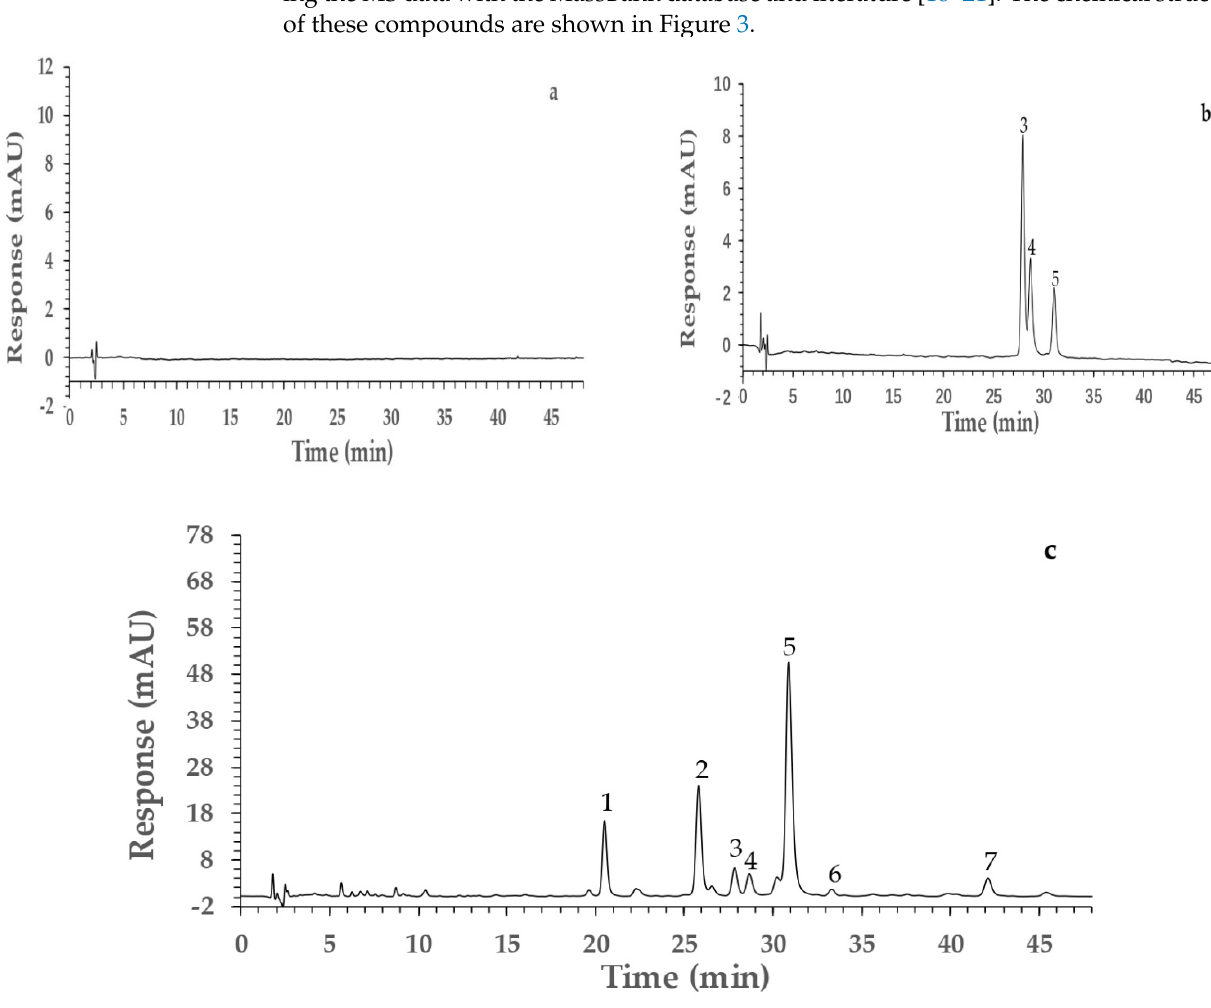
Figure 2. The HPLC chromatograms of a blank sample ( a ), reference compounds ( b ), and PVR ( c ). Quercetin − 3 − O − vicianoside ( 1 ), quercetin 3 − O − neohesperidoside ( 2 ), rutin ( 3 ), hyperoside ( 4 ), quercetin − 3 − O − glucuronide ( 5 ), luteolin − 7 − O − neohesperidoside ( 6 ), kaempferol 3 − glucuronide ( 7 ). Table 1. The MS data of